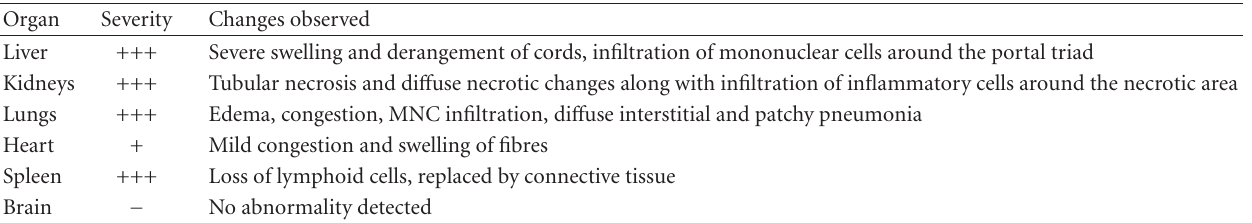
Table 3: Results of histopathological investigations of mice following repeated recombinant PfP0